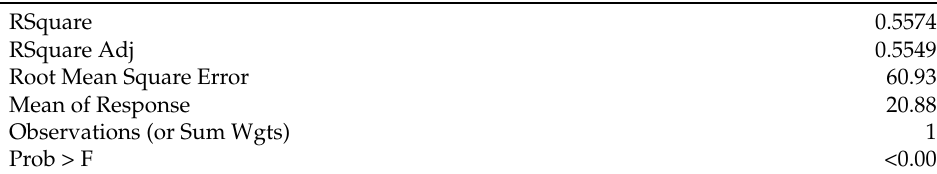
Table 3. Summary of Fit—Analysis of parameters TP and CH 4 dependencies.